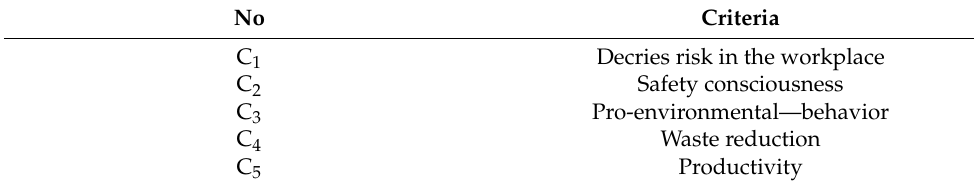
Table 14. The criteria for safety culture factors evaluation. No Criteria C 1 Decries risk in the workplace C 2 C 3